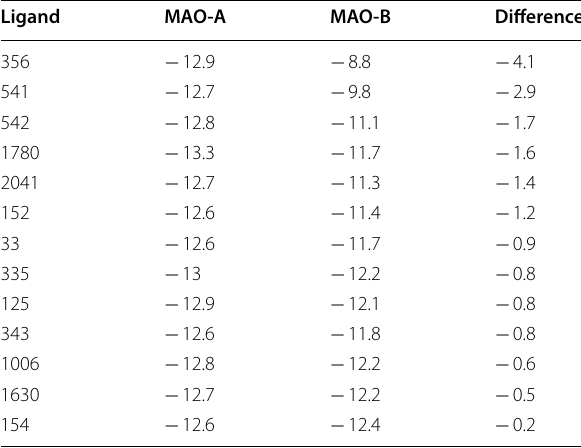
Assays were performed using Autodock VINA software, values are affinity energy (Kcal/mol)